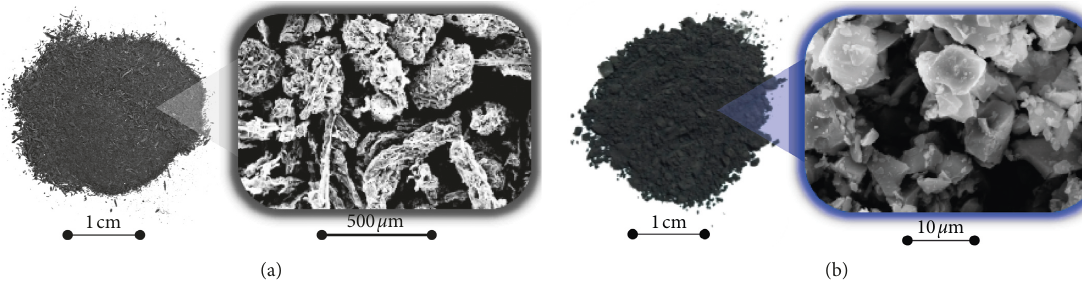
Figure 2: Visual aspects and SEM micrographs of fly sugarcane bagasse ash samples. (a) FSCBA and (b) MFSCBA.